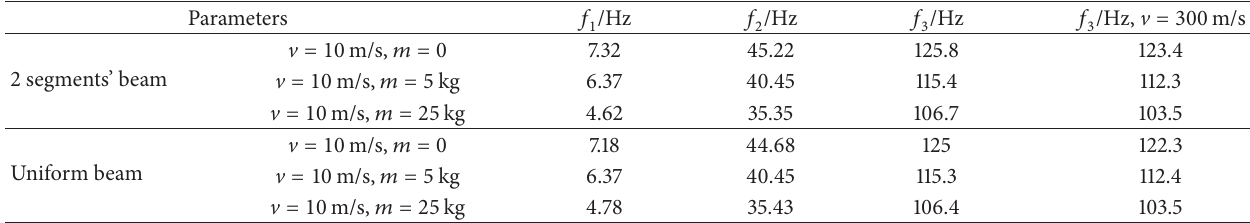
Table 2: Comparison of frequency for three